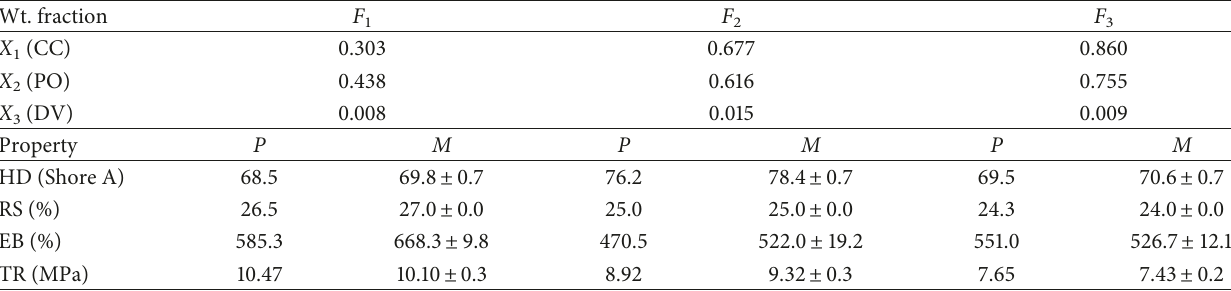
1 , F 2 , and F 3 and corresponding measured ( M ) and predicted ( P )